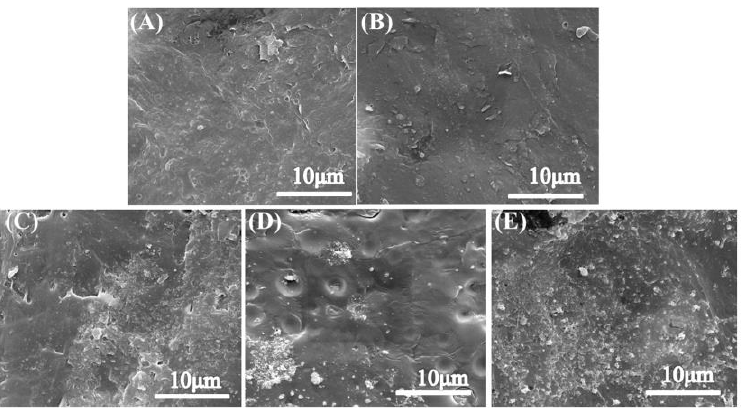
Figure 2. XRD patterns of the nHA-PBP hybrid membranes with different nHA contents.